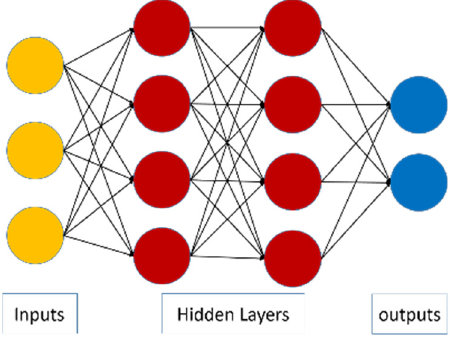
Figure 2. Schematic view of ANN.